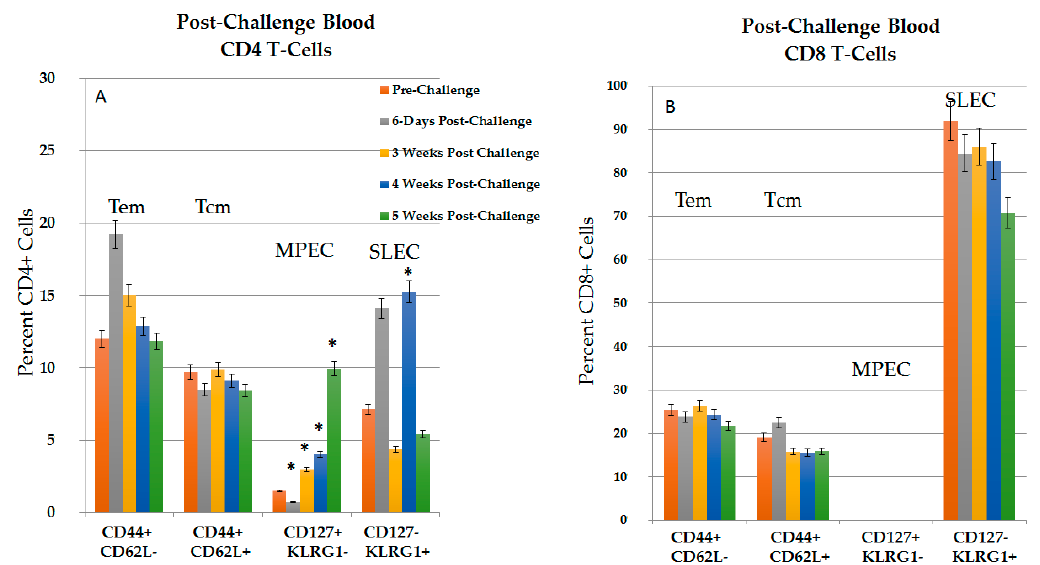
Figure 7. Circulating T-Cells post-challenge show dynamic changes in CD4+ cells. Blood was harvested at various times post-challenge. Lymphocytes were isolated using Ficoll and then stained with CD4, CD8, CD44, CD62L, CD127 and KLRG1. Analyses were done on CD4+ cells ( A ) and CD8+ cells ( B ). n = 9, error bars = SEM. * p < 0.05.